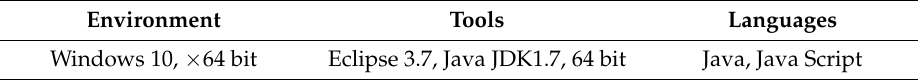
Table 1. Development environments of SPIA.